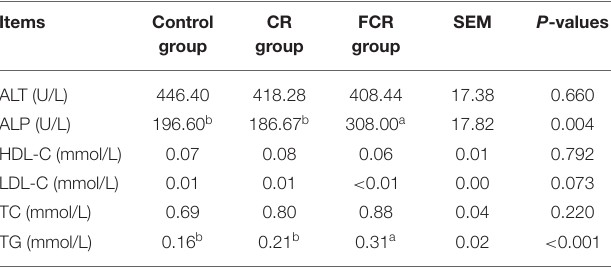
TABLE 1 | Effects of cassava residue (CR) or fermented cassava residue (FCR) on hepatic biochemical parameters of piglets. Items